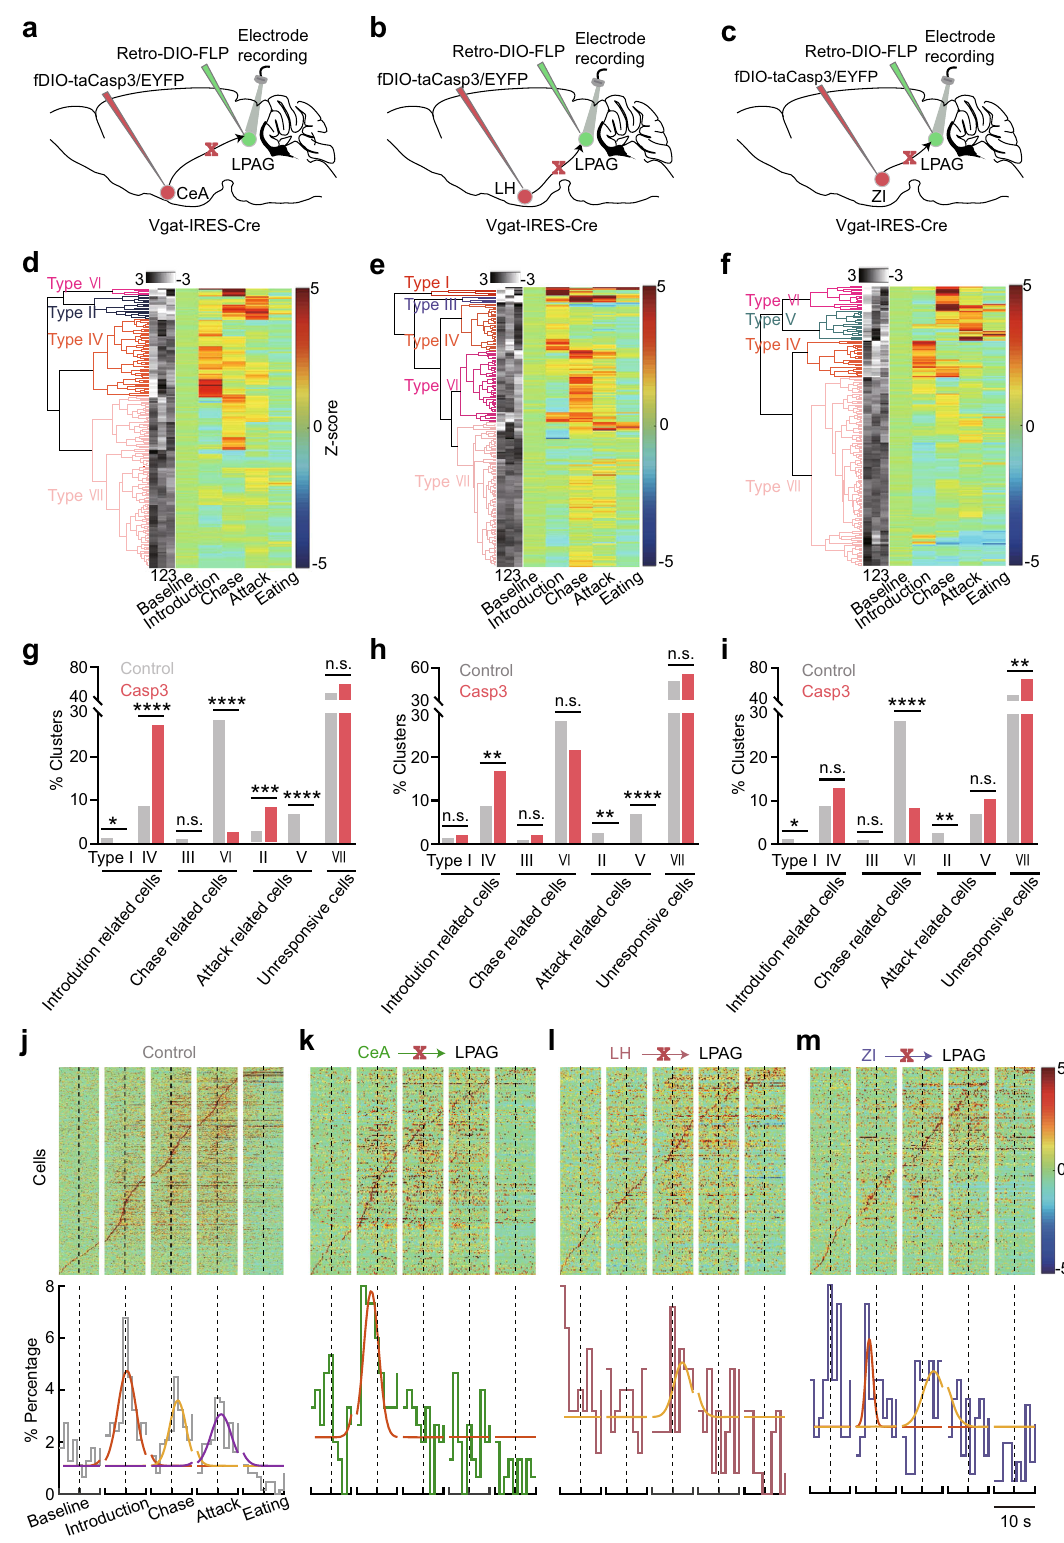
ablation of LPAG-projecting GABAergic neurons from the CeA/ LH/ZI (Fig. 6d). The eating duration was not signi fi cantly different between these lesions (Fig. 6g). Together, these data conclude that removing either of the CeA/LH/ZI inputs to the LPAG is suf fi cient to interrupt all hunting motor actions except eating, including prey detection, chase, attack, and